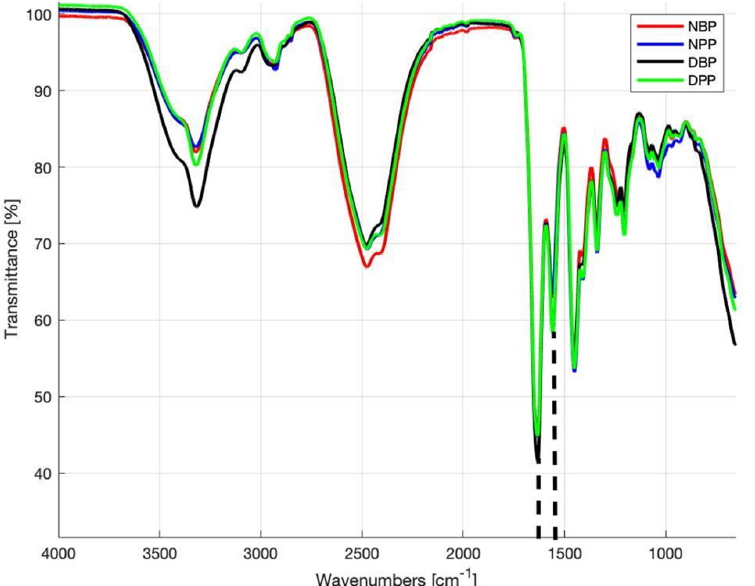
Figure 1. Fourier transform infrared spectroscopy attenuated total reflectance (FTIR-ATR) spectra obtained from the NBPs, NPPs, DBPs, and DPPs samples. Dashed lines identify the peaks at 1630 cm − 1 (amide I) and 1550 cm − 1 (amide II).